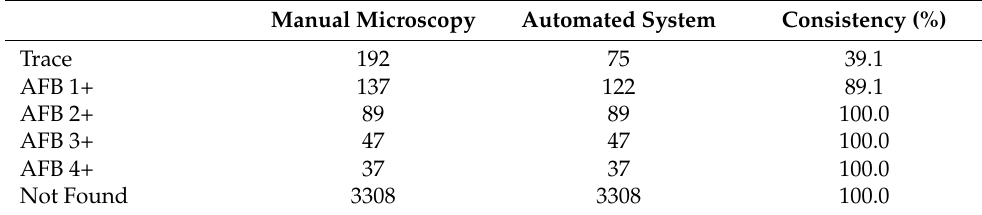
Table 7. The consistency between the automated TB smear microscopy system and manual micro- scopic examination.